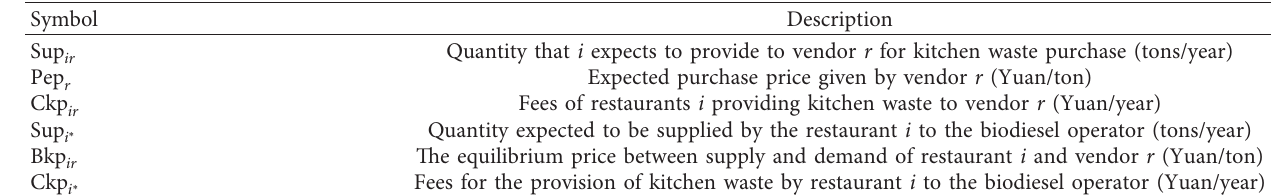
Table 2: Description of the symbols used in the allocation decision